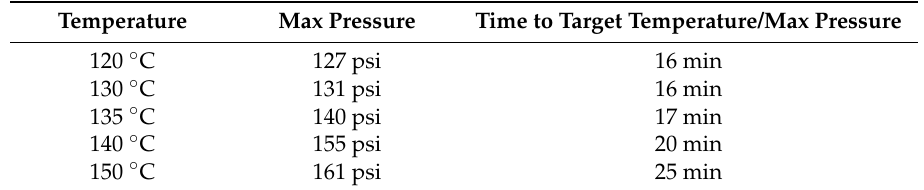
Table 2. Parr vessel solubilization of rMaSp2 with C-term at varying temperatures and